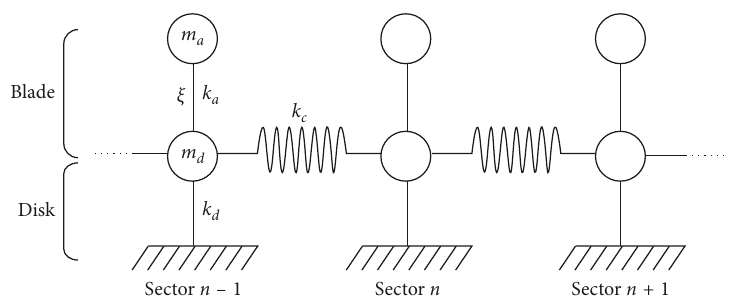
Figure 2: Two degrees of freedom per sector model.